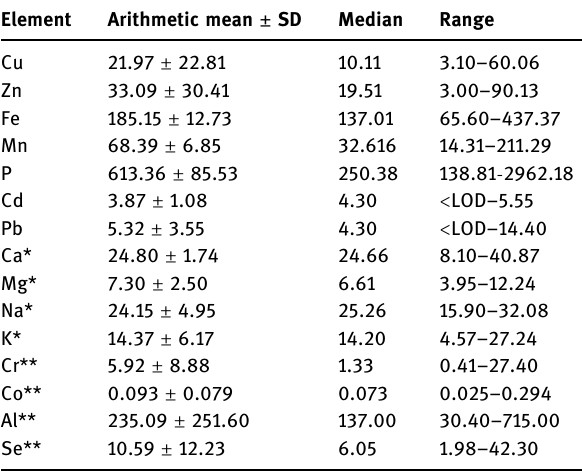
Table 3: Results of element determination in ten medicinal plants from Congo